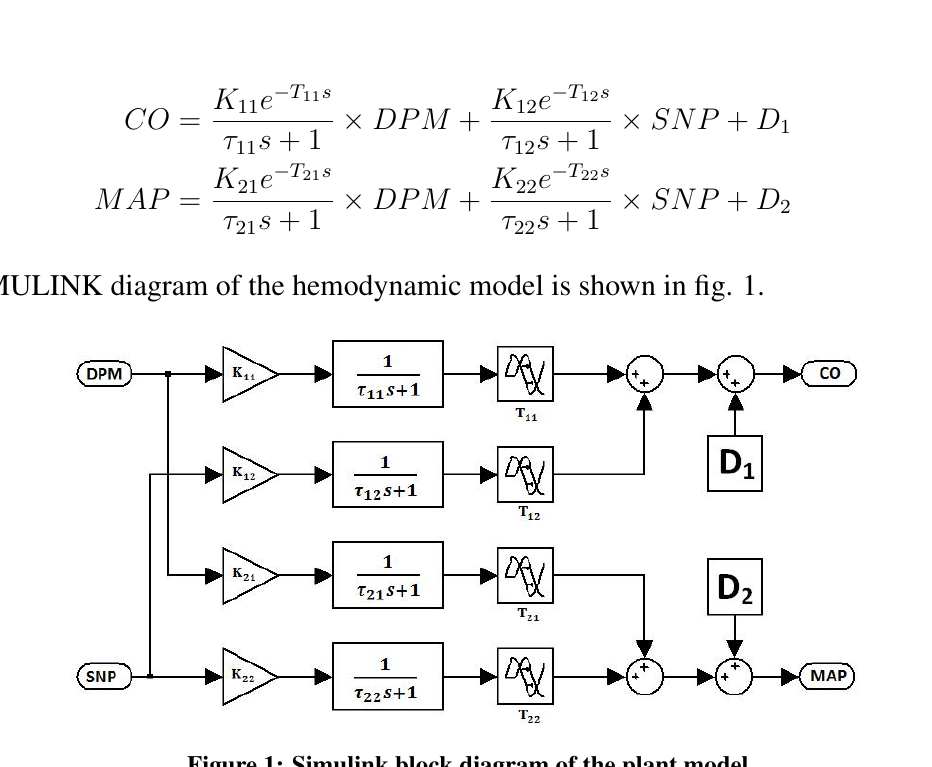
Figure 1: Simulink block diagram of the plant model